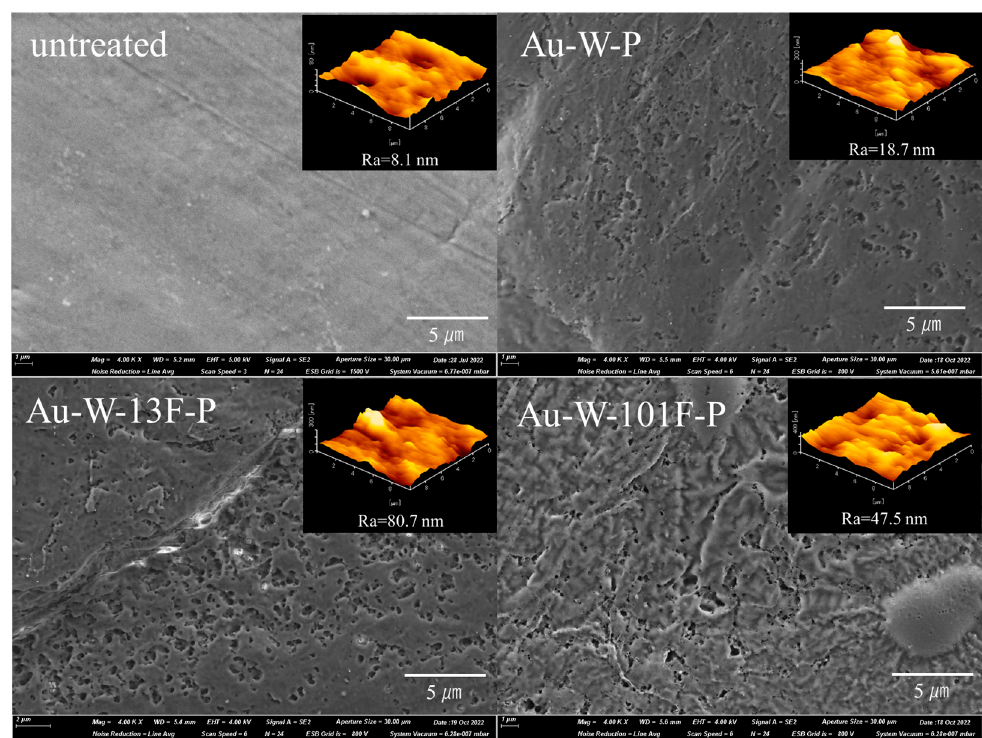
Figure 3. SEM images and AFM images of various PTFE samples.